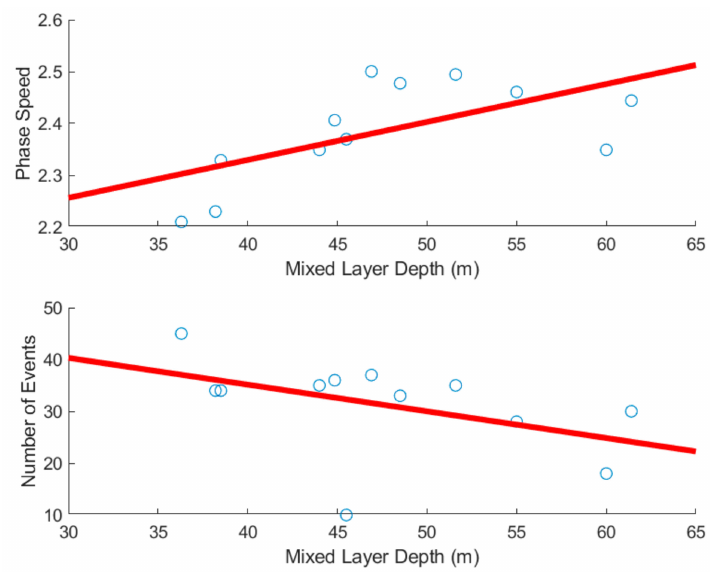
Figure 4. Monthly averaged mixed layer depth vs. monthly averaged phase speed ( top ) and frequency of events ( bottom ). The circles represent the model data while the red line provides the best linear